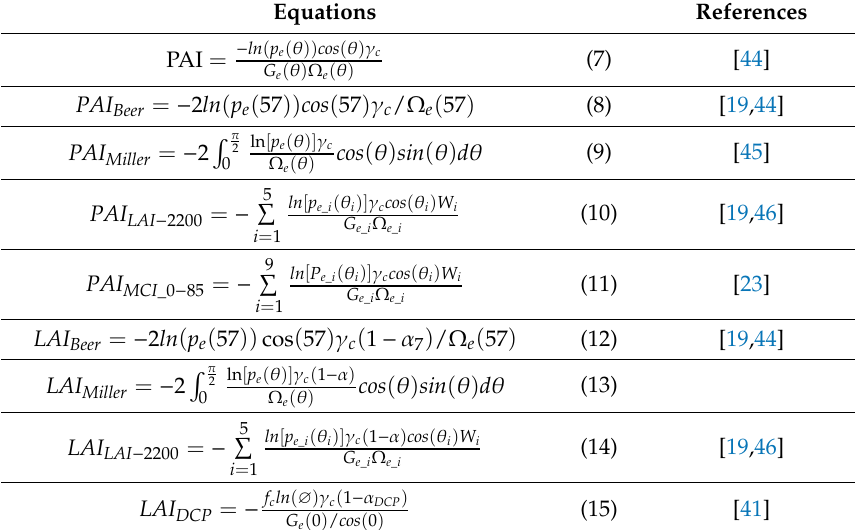
Table 2. The inversion model formulae used for the plant area index (PAI), wood area index (WAI), and leaf area index (LAI) estimations in this study. γ c is the corrected needle-to-shoot area ratio. G e ( θ ) is the canopy element projection coe ffi cient ( G e ) at θ . G e _ i is the G e of the i th annulus. Ω e ( θ ) is the Ω θ derived from the gap size distribution (CC), logarithmic averaging (LX), and combination of e at gap size and logarithmic averaging (CLX) using Equations (1)–(3), respectively. p e ( 57 ) and Ω e ( 57 ) are the canopy element gap fraction and Ω e measurements obtained at the zenith angle range of 52 ◦ –62 ◦ , respectively. θ i , p e _ i ( θ i ) , Ω e _ i , and W i are the center zenith angle, canopy element gap fraction, Ω e and weight factor of the i th annulus of digital hemispherical photography (DHP) or multispectral canopy imager (MCI), respectively. For the LAI-2200 method, the zenith angle ranges of the five annuli are 0 ◦ –13 ◦ , 16 ◦ –28 ◦ , 32 ◦ –43 ◦ , 47 ◦ –58 ◦ , and 61 ◦ –74 ◦ , respectively [19,46]. The W i of the five annuli of LAI-2200 are 0.041, 0.131, 0.201, 0.29, and 0.337, respectively [19,46]. For MCI, the zenith